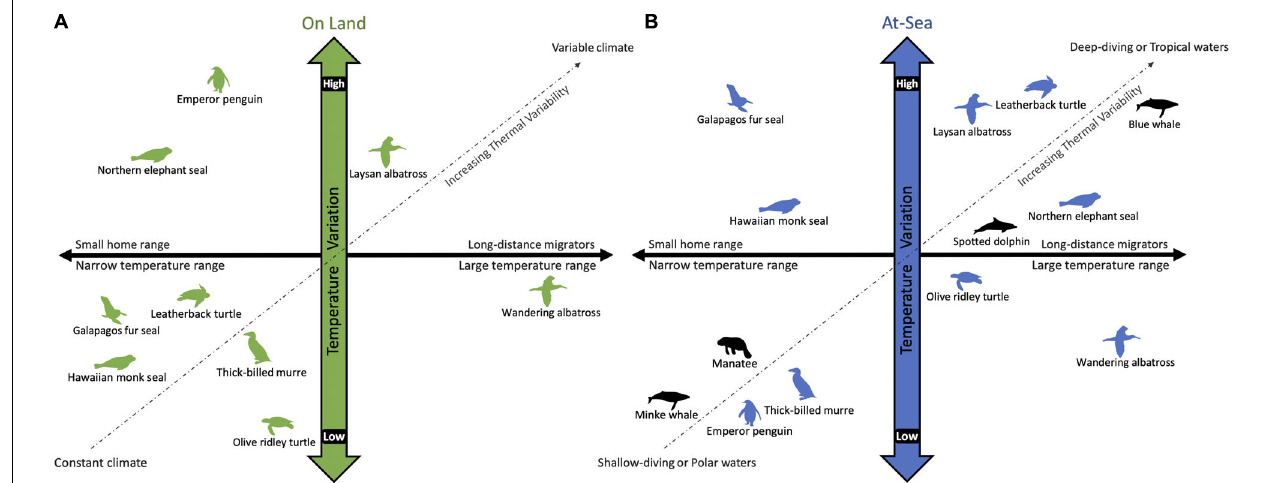
FIGURE 1 | A schematic comparing the variation in temperature experienced by air-breathing marine vertebrates while on land (A) and diving at-sea (B) . The horizontal axis considers the temperature range experienced by horizontal movement across their home range, whereas the vertical axis considers temperature variability due to climate (on land) and water temperature at depth (at-sea). Unlike fully aquatic species (black), amphibious species (green and blue) partition their time between air and water, which have vastly different thermal properties. The extent of their habitat range (i.e., horizontal and vertical) dictates the thermal variability encountered in each environment. For example, the Galápagos fur seal has a limited home range and is exposed to a relatively constant tropical climate (A) . Yet, the cold upwelling waters off the Galápagos Islands introduces a large temperature gradient for diving animals (B) . The wandering albatross is on the opposite side of the continuum as it covers large distances while flying (A) , but remains in the temperate latitudes and feeds in shallow waters (B) . In contrast, blue whales migrate from polar foraging grounds to tropical breeding grounds, experiencing a large temperature range horizontally, as well as vertically during deep dives, although less so when diving in polar waters that are homogenously cold throughout the water column (B)